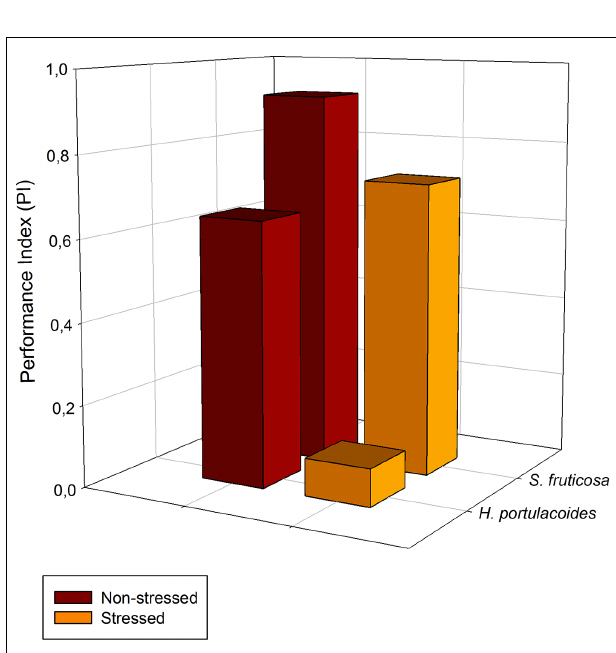
FIGURE 7 | Performance Index (PI) derived from the OJIP-test, in field stressed (orange) and non-stressed individuals (brown) of S. fruticosa and H. portulacoides species (average values, N = 5).